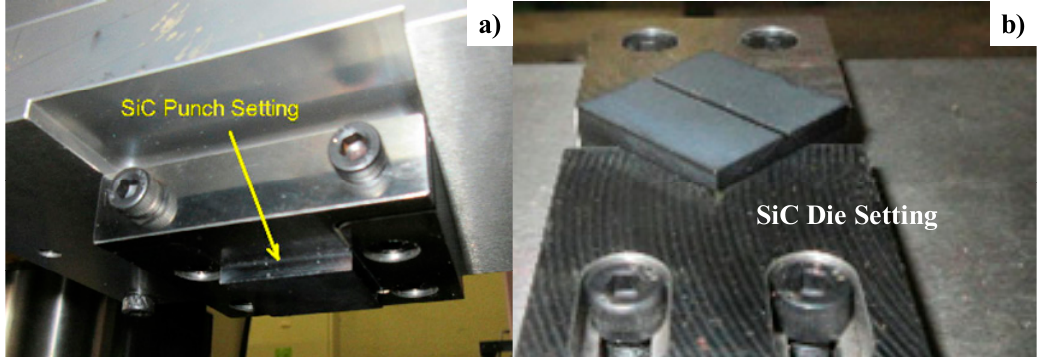
Figure 3. A cassette die set for the dry, cold forging process to be fixed between the upper and lower bolsters in the computer numerical control (CNC) stamper. ( a ) Upper die unit with a SiC punch and ( b ) lower one with a SiC core die.